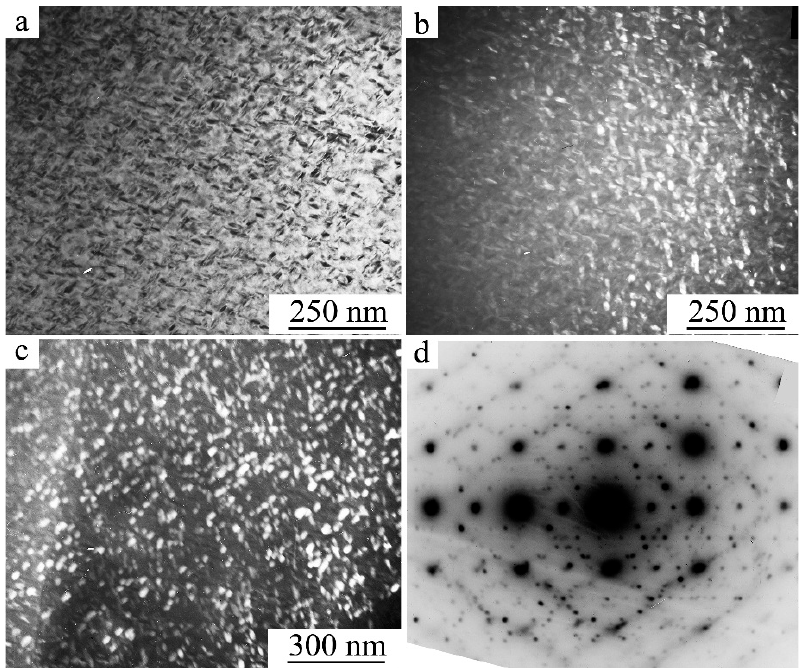
Figure 16. ( a ) Bright- and ( b , c ) dark-field TEM images of the microstructure, and ( d ) the corresponding SAED pattern (z.a. [110] B 2 , SD 1.0 µm), of the Ti 49 Ni 51 alloy after HT at 673 K for 1 h.